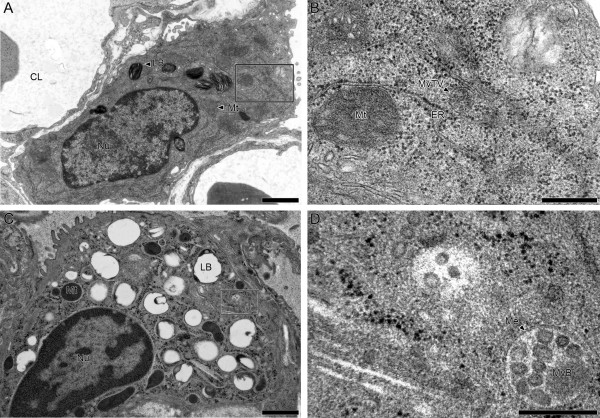
Chemical and physical fixation of the lung. Alveolar epithelial type II cells were studied by cTEM either after chemical (A and B) or after physical (C and D) fixation. The overview in A shows a well-preserved type II cell from a newborn rat lung fixed by instillation of 1.5% GA, 1.5% PFA in Hepes buffer and processed according to Table 1. Lamellar bodies (LB), nucleus (Nu) and mitochondria (Mt) are well preserved. At a higher magnification, details of the endoplasmic reticulum (ER) as well as an ER related multivesicular transport vesicle (MvTV) can be visualized. The overview in C shows a well-preserved type II cell from an adult rat lung. A small piece of tissue was cut from the whole lung, put in a syringe with 1-hexadecene and air was extracted from the tissue block by negative pressure. Afterwards, the specimen was high-pressure frozen (Leica EMPact 2.0, Leica, Vienna, Austria), freeze-substituted with acetone containing 1% osmium tetroxide (AFS 2.0, Leica, Vienna, Austria) and embedded in epoxy resin. Most likely due to the lack of uranyl acetate during freeze-substitution the lamellar bodies are not well preserved, with almost complete loss of the surfactant material, only the limiting membrane can be seen. However, the ultrastructure of other organelles like multivesicular bodies (MvB) is highly increased (D) due to the excellent preservation of the membrane structures (Me). Since this is the first description of high-pressure frozen lung tissue, systematic studies are needed to determine the ideal processing both for conventional and immuno TEM. Bars = 1 μm (A, C), 250 nm (B, D).